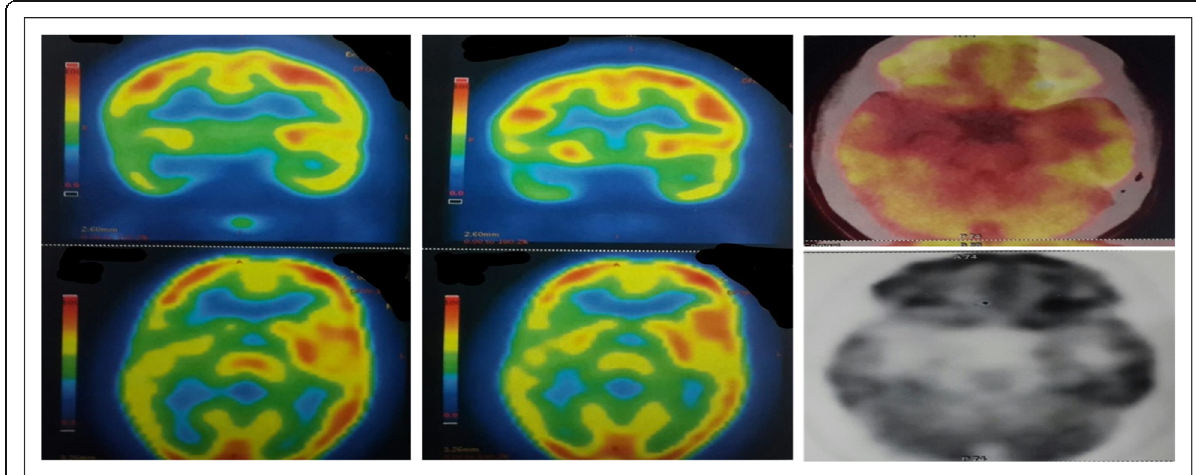
Fig. 3 18-FDG-PET/CT scan showing interictal hypometabolism with reduced tracer avidity of the right medial temporal